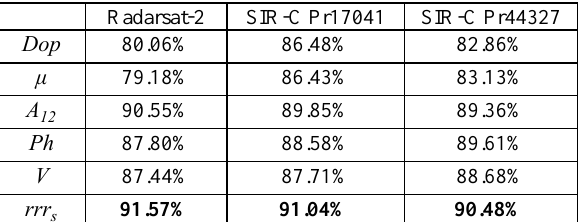
Table 5. The F 1 score of classification using different features within three